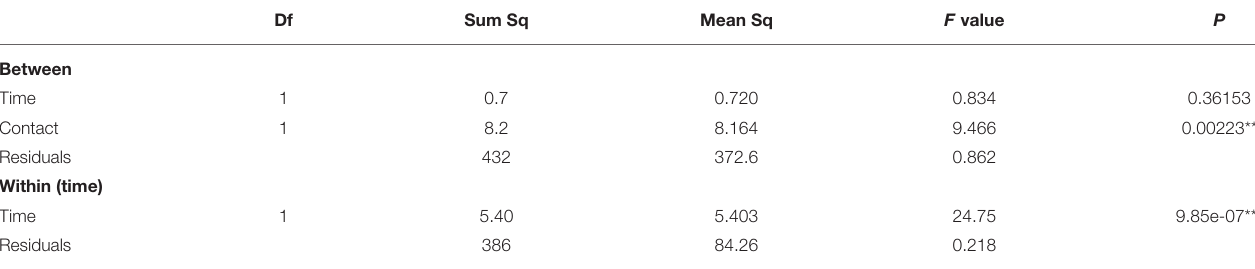
TABLE 4 | Analysis of variance (generalized mixed model).